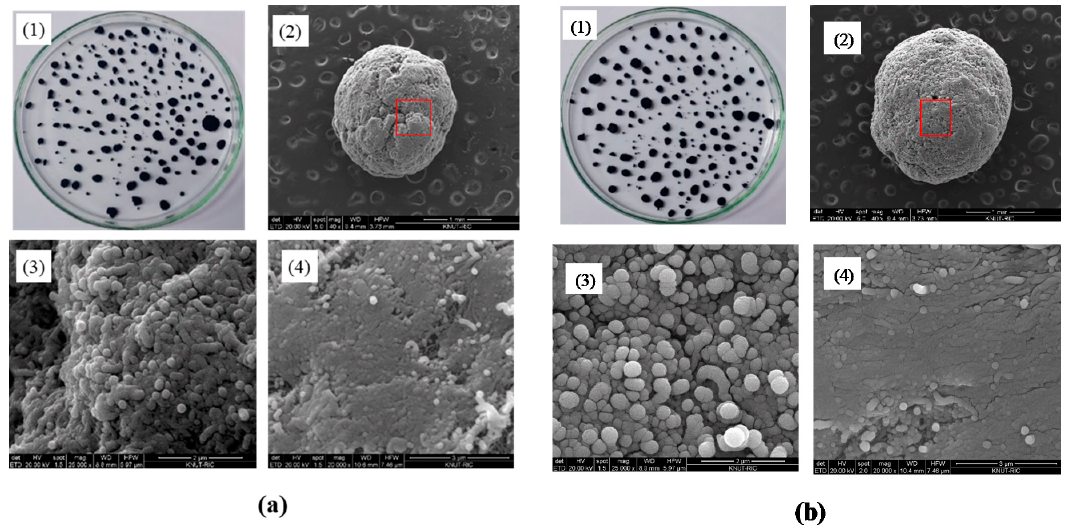
Figure 3. Magnified and SEM images of CNT microbeads: ( a ) Case I and ( b ) Case II; (1) magnified image, (2) SEM image of microbead (scale bar: 1 mm), (3) SEM image of internal pore (scale bar: 2 µ m), (4) SEM image of surface (scale bar: 3 µ m). Table1. Physicalpropertiesof rawmultiwalledCNT(MWCNT) powderandprepared CNTmicrobeads.